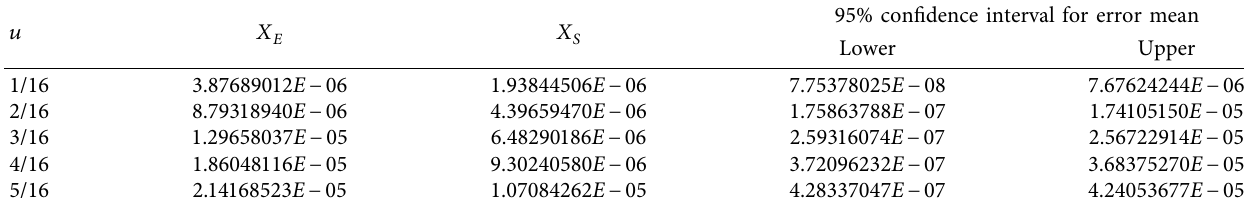
Table 2: When m � 16 and H � 0 . 8, the table exhibits numerical results of Example 1.